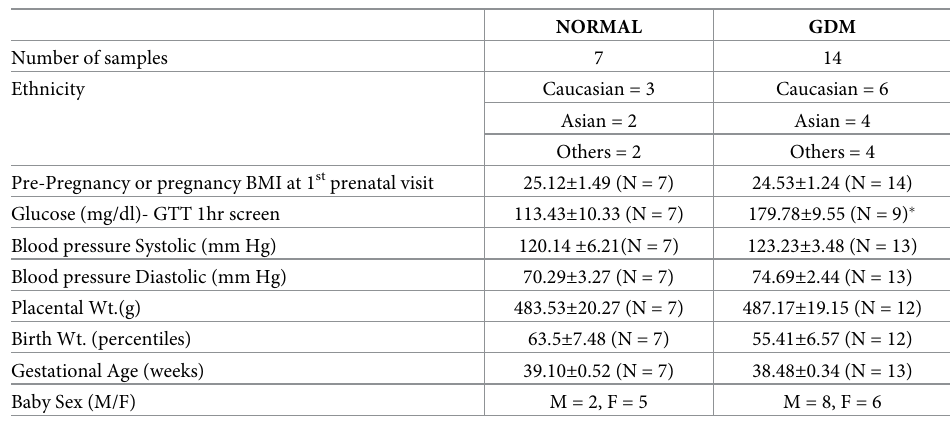
Table 1. Clinical